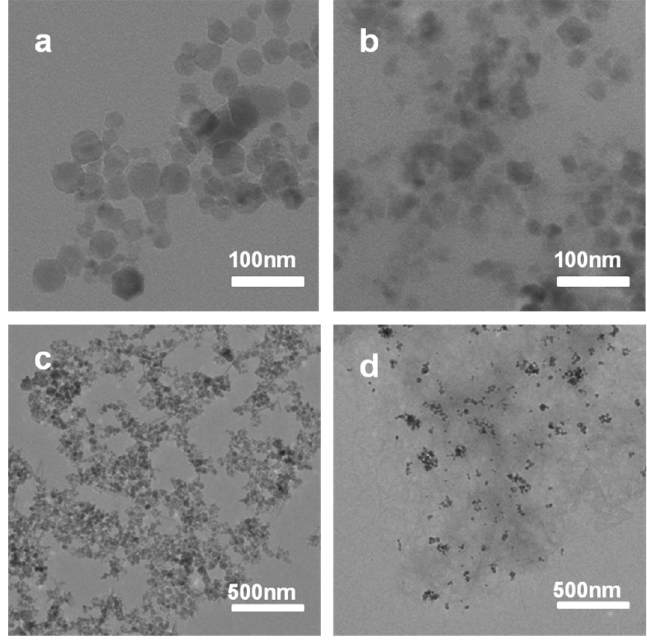
Figure 3. TEM micrographs of ( a ) and ( c ) the CA-Fe 3 O 4 NPsdispersed in water at different magnification; ( b ) and ( d ) the CA-Fe 3 O 4 @Zn/AMP gels dissolved in water at different magnification.